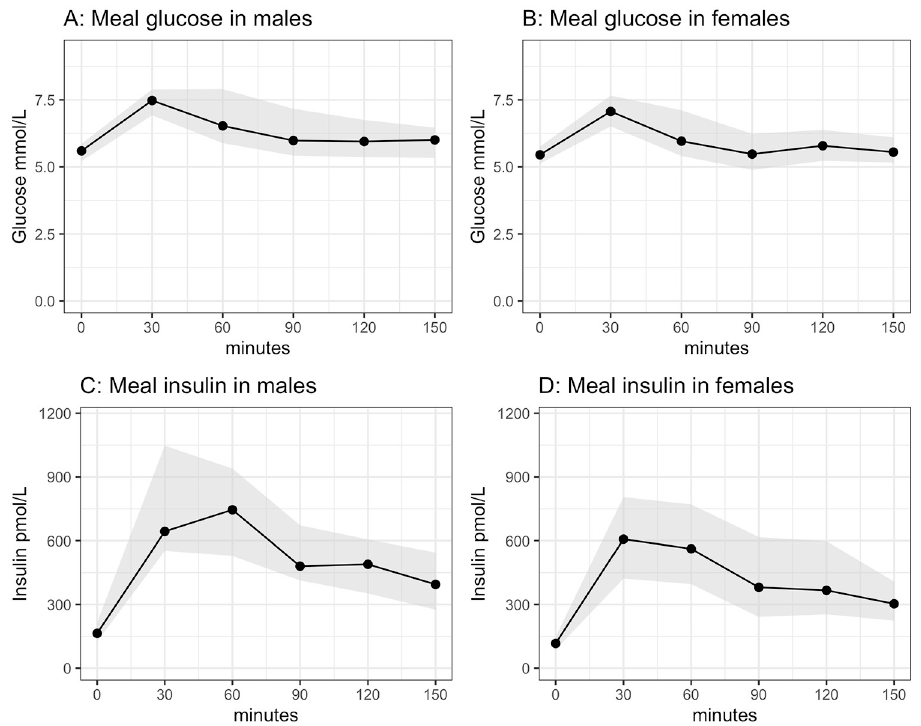
Fig 2. Median fasting and postprandial glucose and insulin levels during meal test. Black circles connected with black solid line show medians, and light grey area shows the area from the 25th (Q1) to the 75th percentile (Q3). Glucose in upper row (A, B) and insulin in the bottom row (C, D), with males in the left columns and females in the right columns.